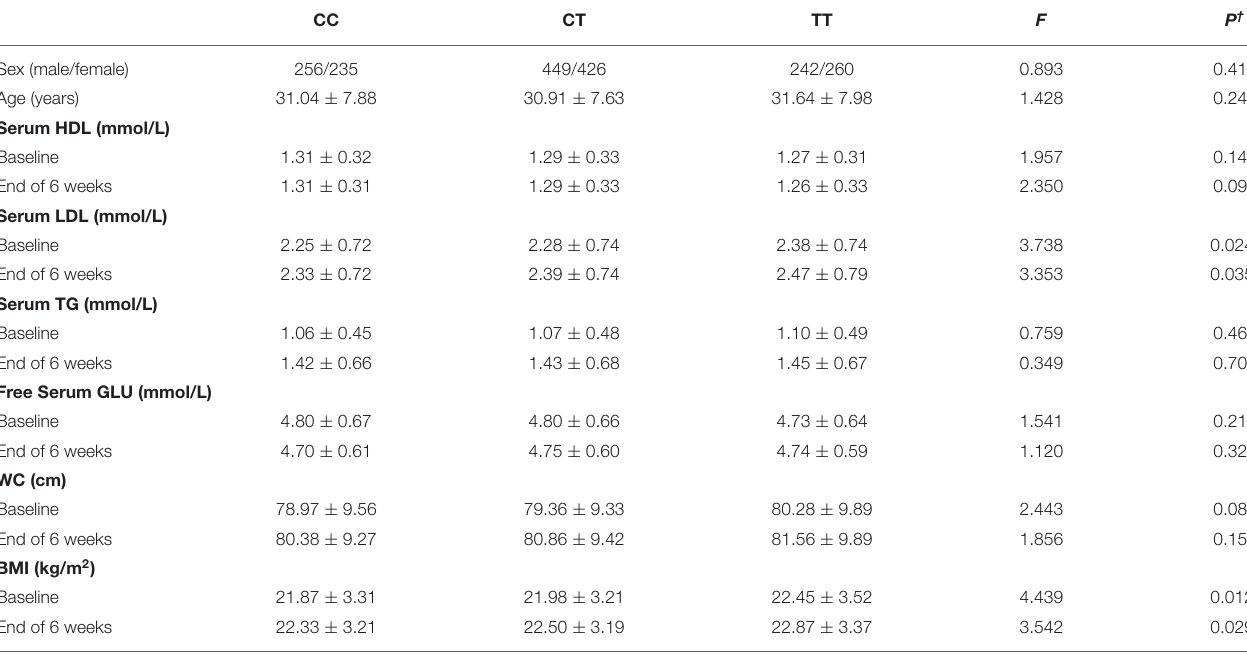
TABLE 2 | Association of MTHFR C677T polymorphism with antipsychotic-induced metabolic index at both baseline and after 6-week treatment in schizophrenia patients. CC CT TT F P